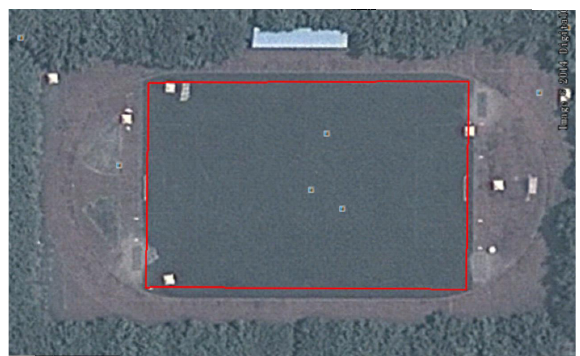
Figure 10. Playground surrounded by trees.